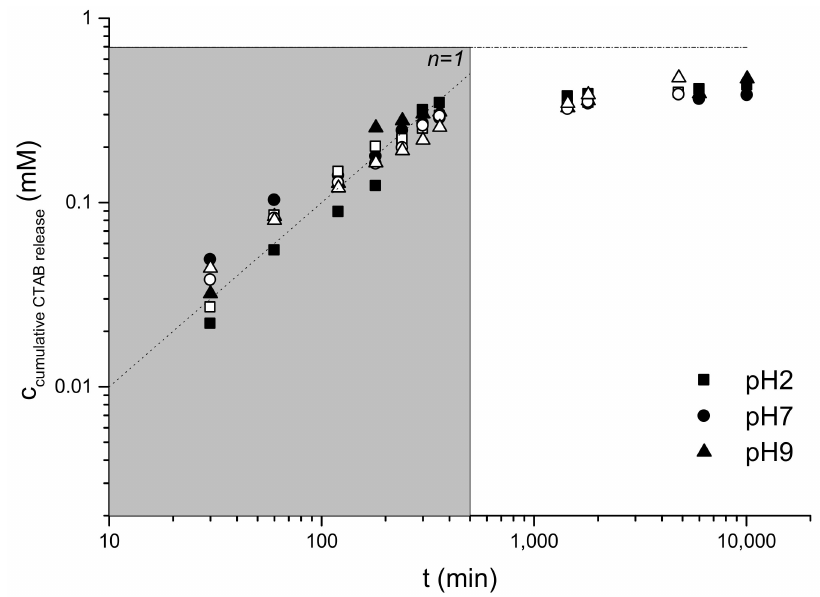
Figure 5. The cumulative released surfactant concentration as a function of time in the different pH solutions for MWNT–DNA–CTAB gel particles (solid symbols) and for PEG–DNA–CTAB gel particles (open symbols). The gray area shows the fast release region. The dashed line in the figure corresponds to the maximum released amount of